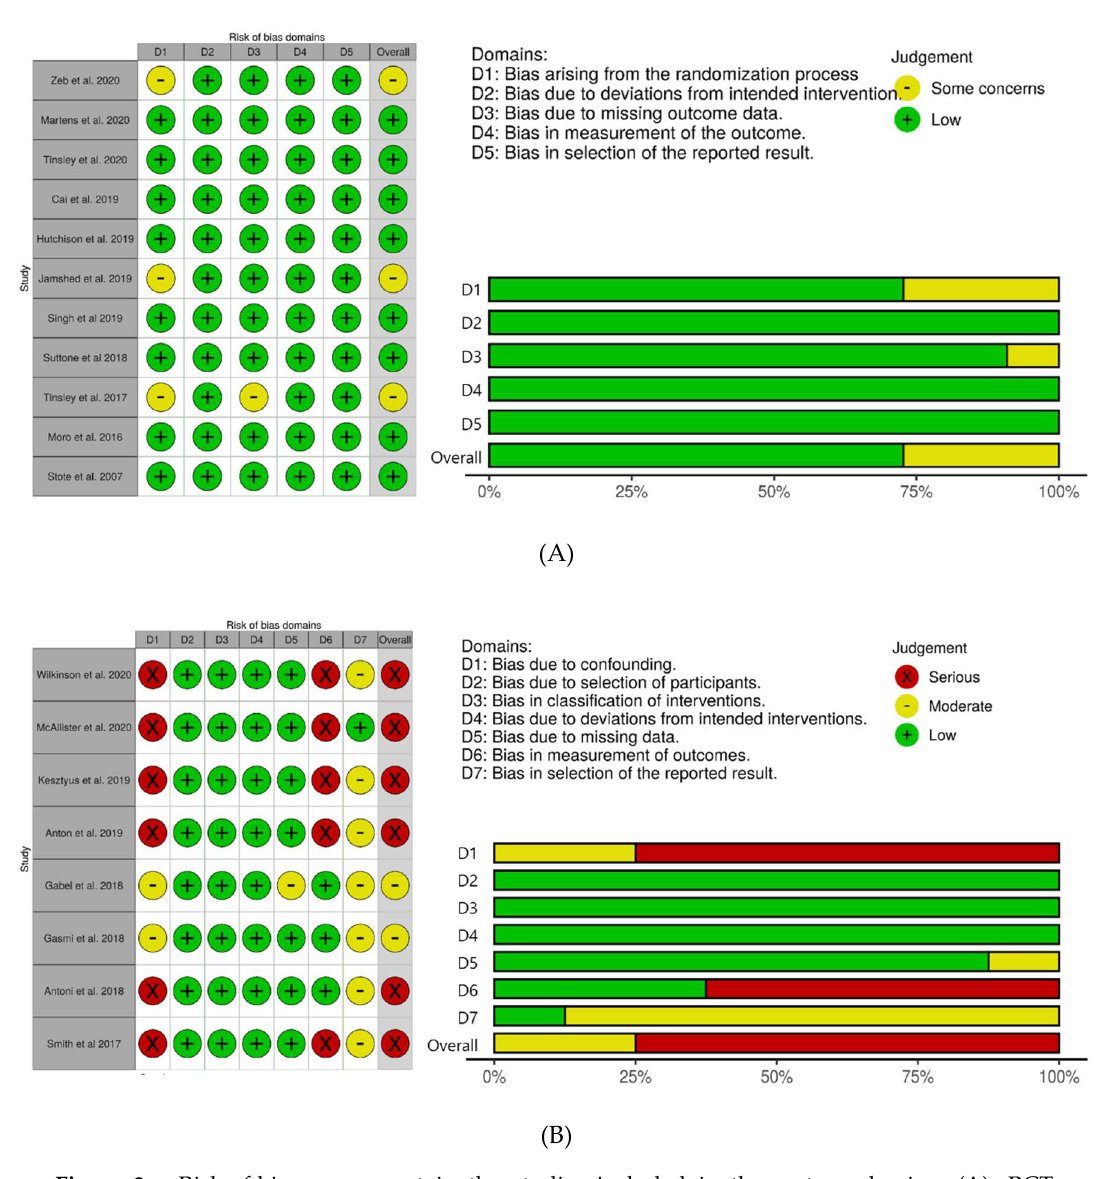
Figure 2. ( A ): RCT, Figure 2. Risk-of-bias assessment in the studies included in the meta-analsysis. A : RCT, B : non- ( B ): non-randomized randomized studies.